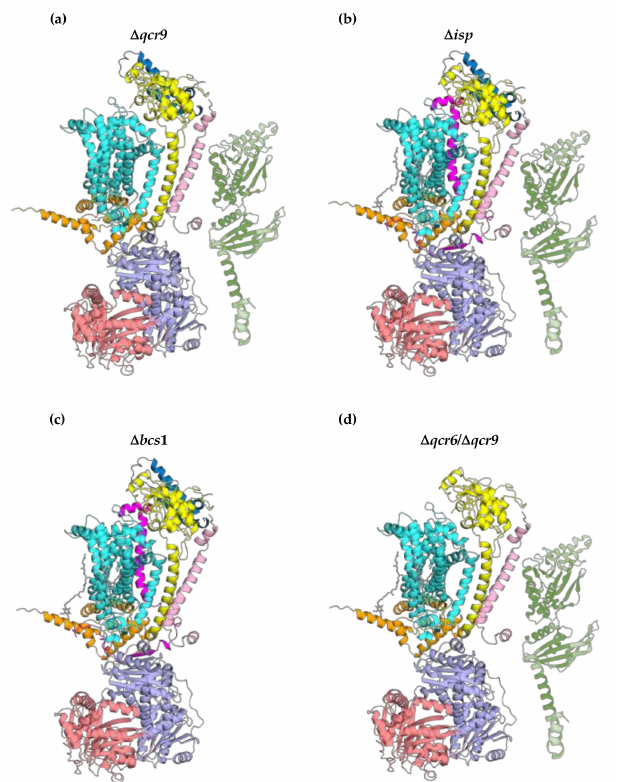
Figure 4. Different forms of the bc 1 late core identified in four yeast mutant strains: ( a ) ∆ qcr9 ; ( b ) ∆ isp ; ( c ) ∆ bcs1 ; ( d ) ∆ qcr6 / ∆ qcr9. The bc 1 late core is depicted in its monomeric form (cytochrome b : aquamarine, cytochrome c 1 : yellow, core protein 1: light blue, core protein 2: salmon, Qcr6p: sky blue, Qcr7p: orange, Qcr8p: pink, Qcr9p: magenta). The Bcs1p structure was obtained